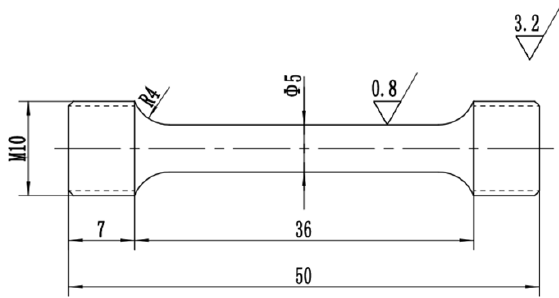
Figure 2. A schematic illustration of the tensile specimens.